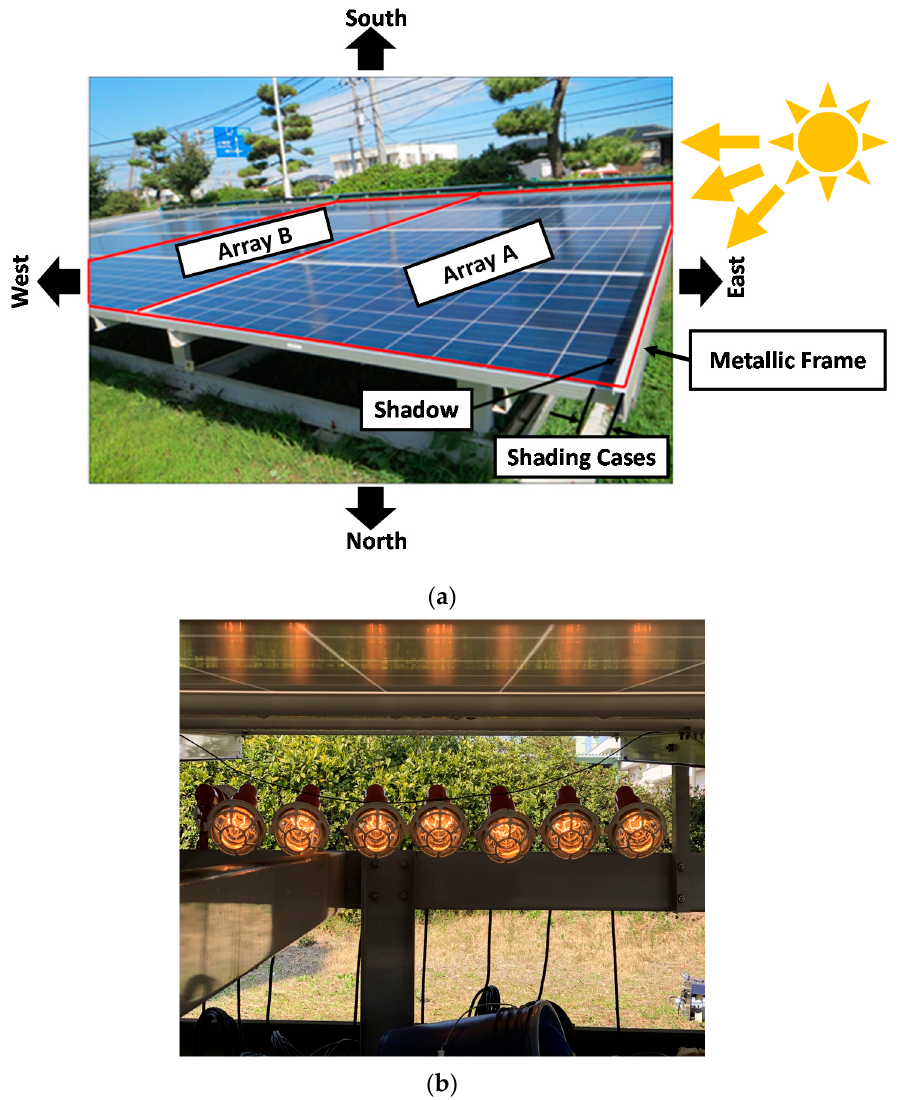
Figure 2. The experimental setup. ( a ) A shadow was introduced on the first PV cells connected with bypass diodes of the PV modules in array A due to the metallic frame and ( b ) eight bulbs connected in parallel. Table 1. Specification of the PV module.